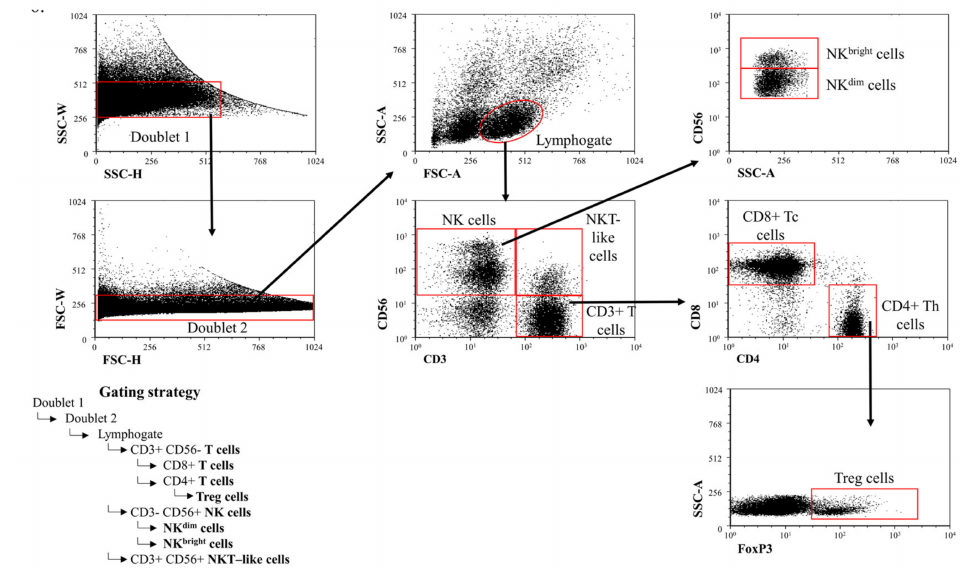
Figure 6. Gating strategy to detect peripheral immune cell populations. Gating technique used to detect immune cell populations in the